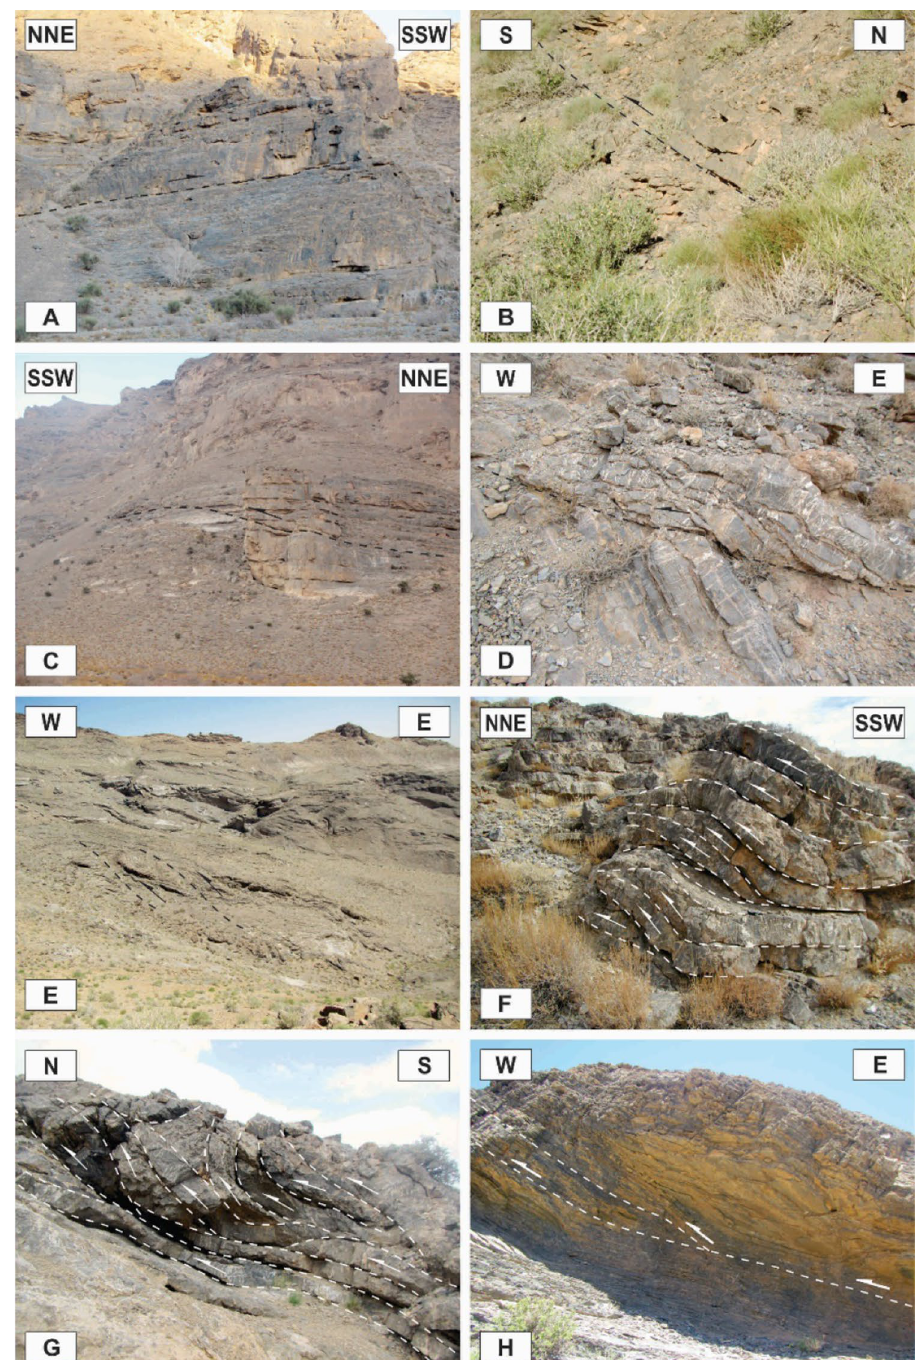
Figure 11. Annotated field photograph of the examples of the outcrop-scale thrust faults and duplex structures. (Photos are taken by Mohammad Ali